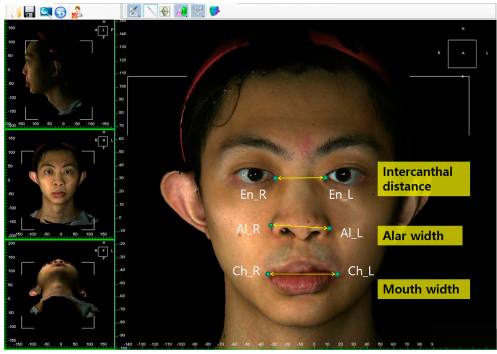
Figure 2. Representation of intercanthal distance, alar width, and mouth width.